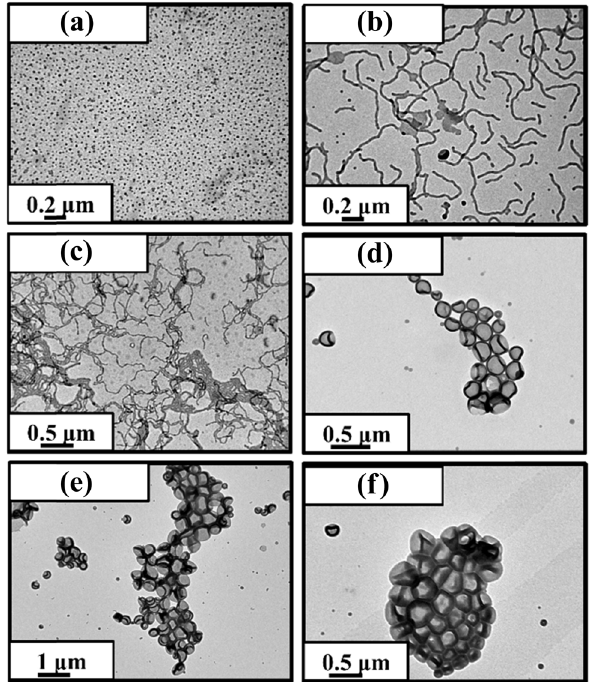
Figure 2: TEM micrographs for PDMA 43 - b - P ([ BVBIm ][ PF 6 ]) x nano - objects synthesized at 25% w/v solids and 70°C: ( a ) x = 28, ( b ) x = 34, ( c ) x = 39, ( d ) x = 43, ( e ) x = 48, and ( f ) x =